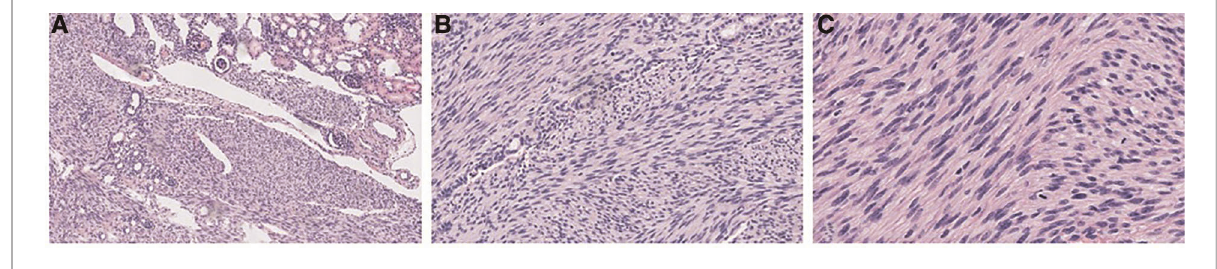
FIGURE 5 Microscopic images with haematoxylin and eosin (H&E) stain at different magni fi cations. ( A ) 100× magni fi cation; ( B ) 200× magni fi cation; ( C ) 400× magni fi